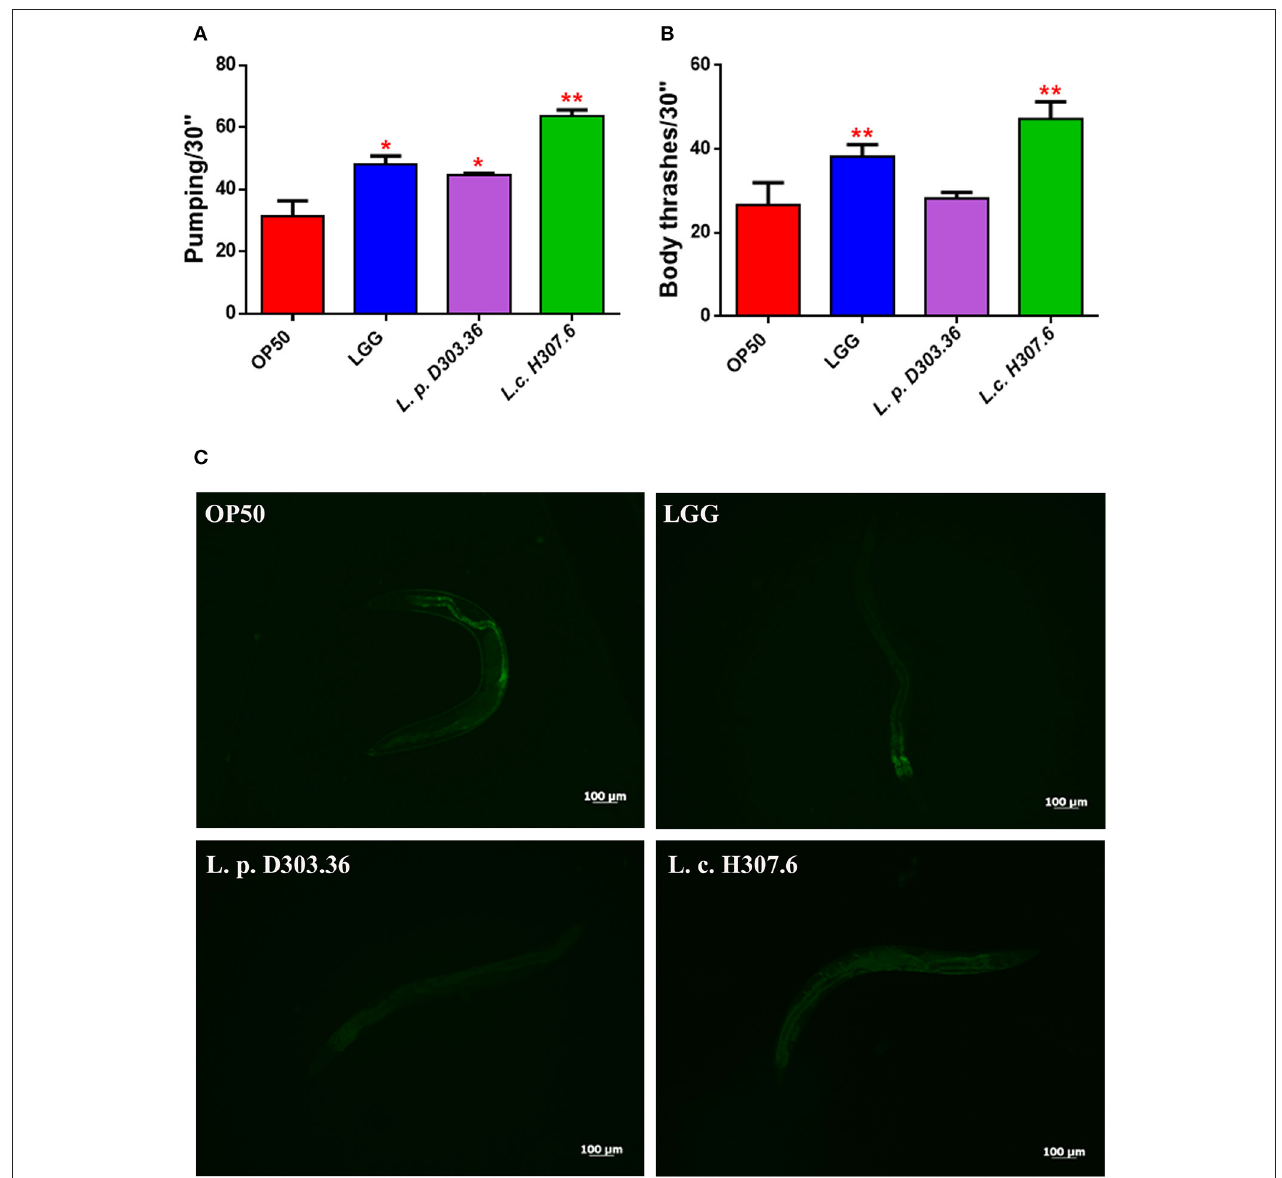
FIGURE 3 | Analysis of aging markers in C. elegans fed the L. pentosus D303.36 and L. coryniformis H307.6 strains. (A) Pumping rate of 13-days-old worms, measured for 30s and determined from the mean of 10 worms for each bacterial strain. Worms fed OP50 or LGG were used as controls. (B) Body bend frequency, measured for 30s, of C. elegans fed different Lactobacillus strains or OP50. Statistical analysis was performed by one-way ANOVA with the Bonferroni post-test ; asterisks indicate significant differences (* p < 0.05, ** p < 0.01). (C) Autofluorescence of lipofuscin granules in C. elegans fed different bacterial strains on day 13. Ten worms were used for each measurement. Scale bar = 100 µ